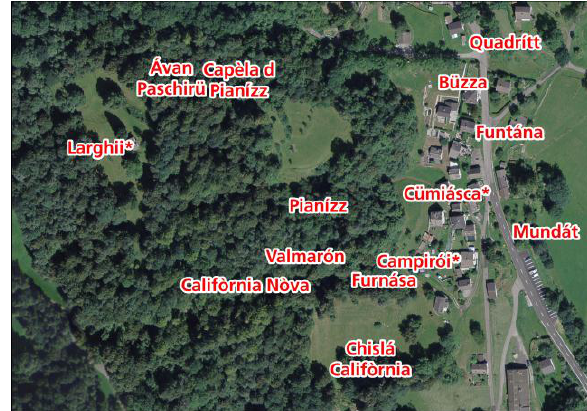
Figure 4: Localization of place names on recent orthophotos may reach a good precision, but many of the sites are hardly recognizable because of the new colonization by forests.